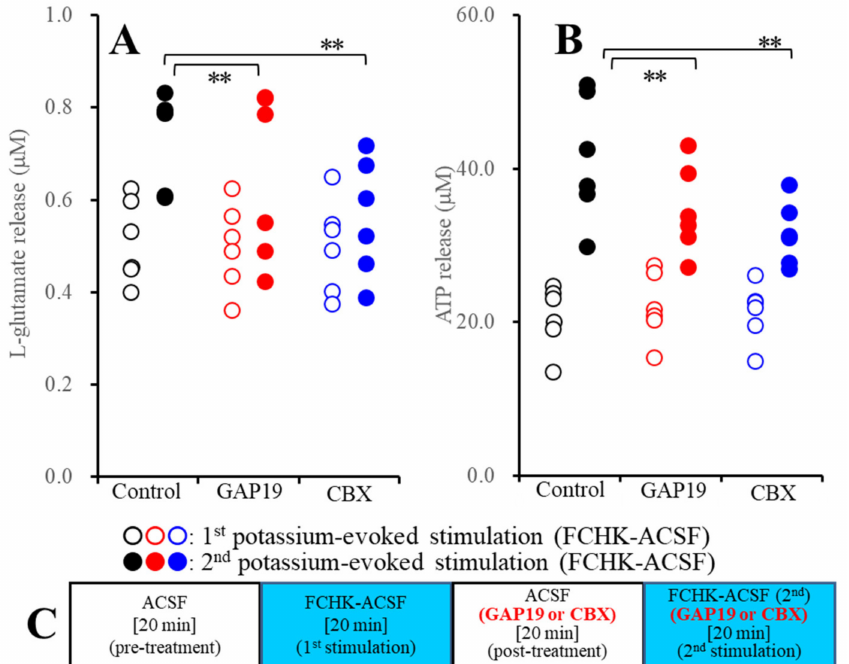
Figure 2. E ff ects of the hemichannel inhibitors (20 µ M GAP19 and 100 µ M CBX) on the astroglial release of ( A ) l -glutamate, ( B ) ATP induced by FCHK-ACSF associated with activated astroglial hemichannels, and ( C ) the experimental design. Ordinate: mean ± SD ( n = 6) of the levels of l -glutamate ( µ M) and ATP (nM). ** p < 0.01 relative to the control by two-way ANOVA with Tukey’s post-hoc